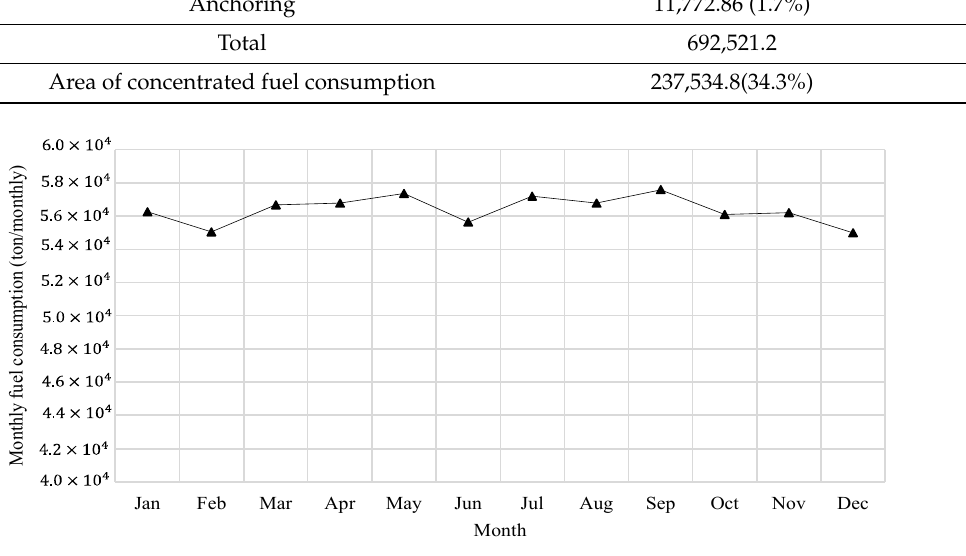
Figure 5. Monthly fuel consumption in BP in 2019.